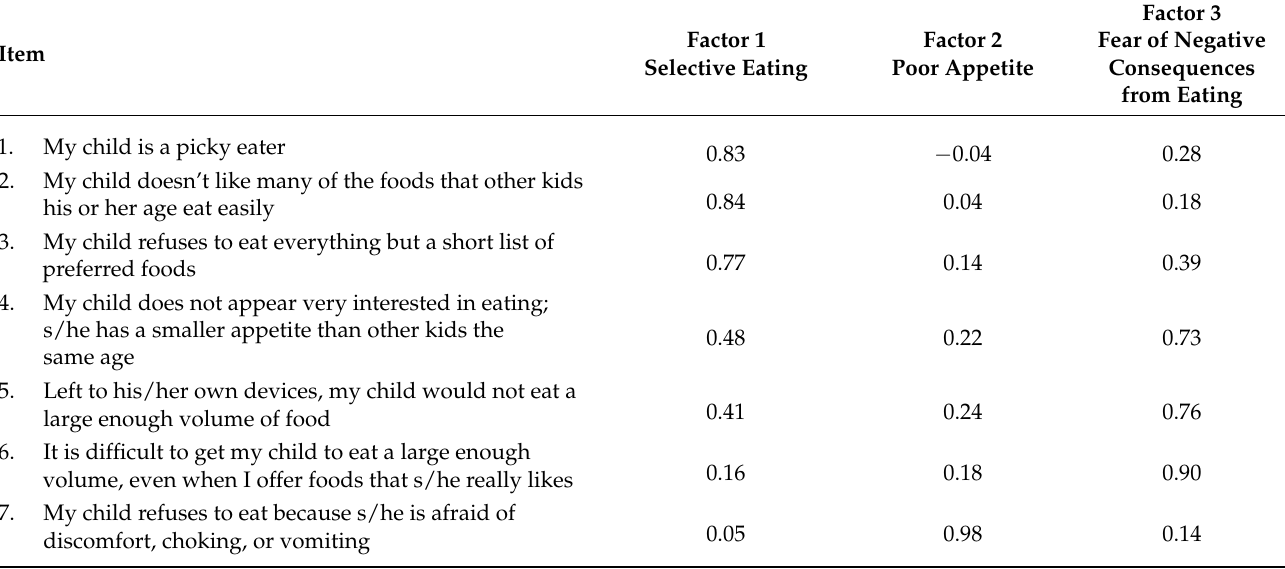
Table 6. EFA NIAS-PR factor analysis (N =